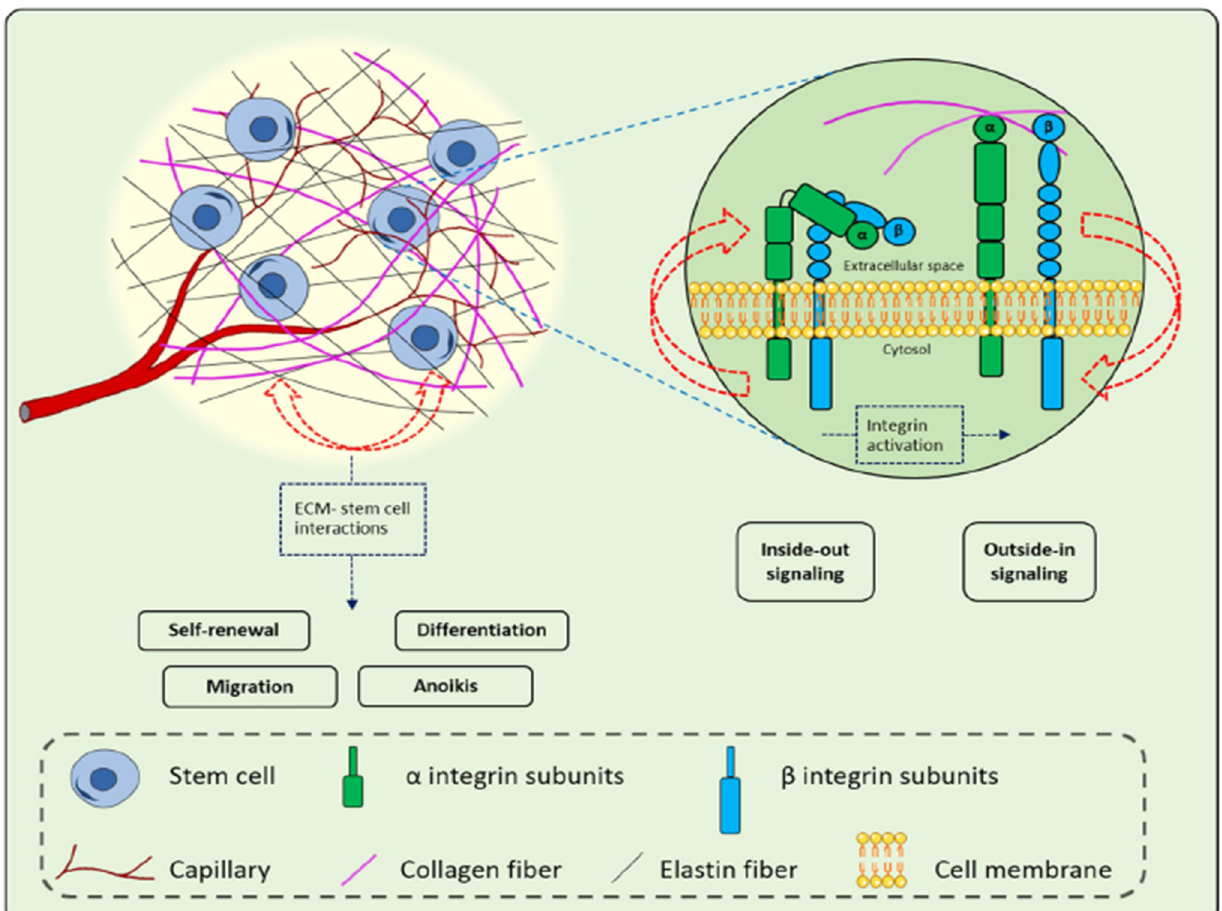
Figure 5. Interactions of the ECM fibers and stem cell integrins through inside-out signaling and outside-in signaling for the modulation of cell migration, proliferation, and differentiation during the wound healing process. Inside-out signaling allows integrins to interact with ECM fibers for integrin activation, while outside-in signaling produces the desired changes in stem cells. Reproduced from ref. [240] with permission from Elsevier.